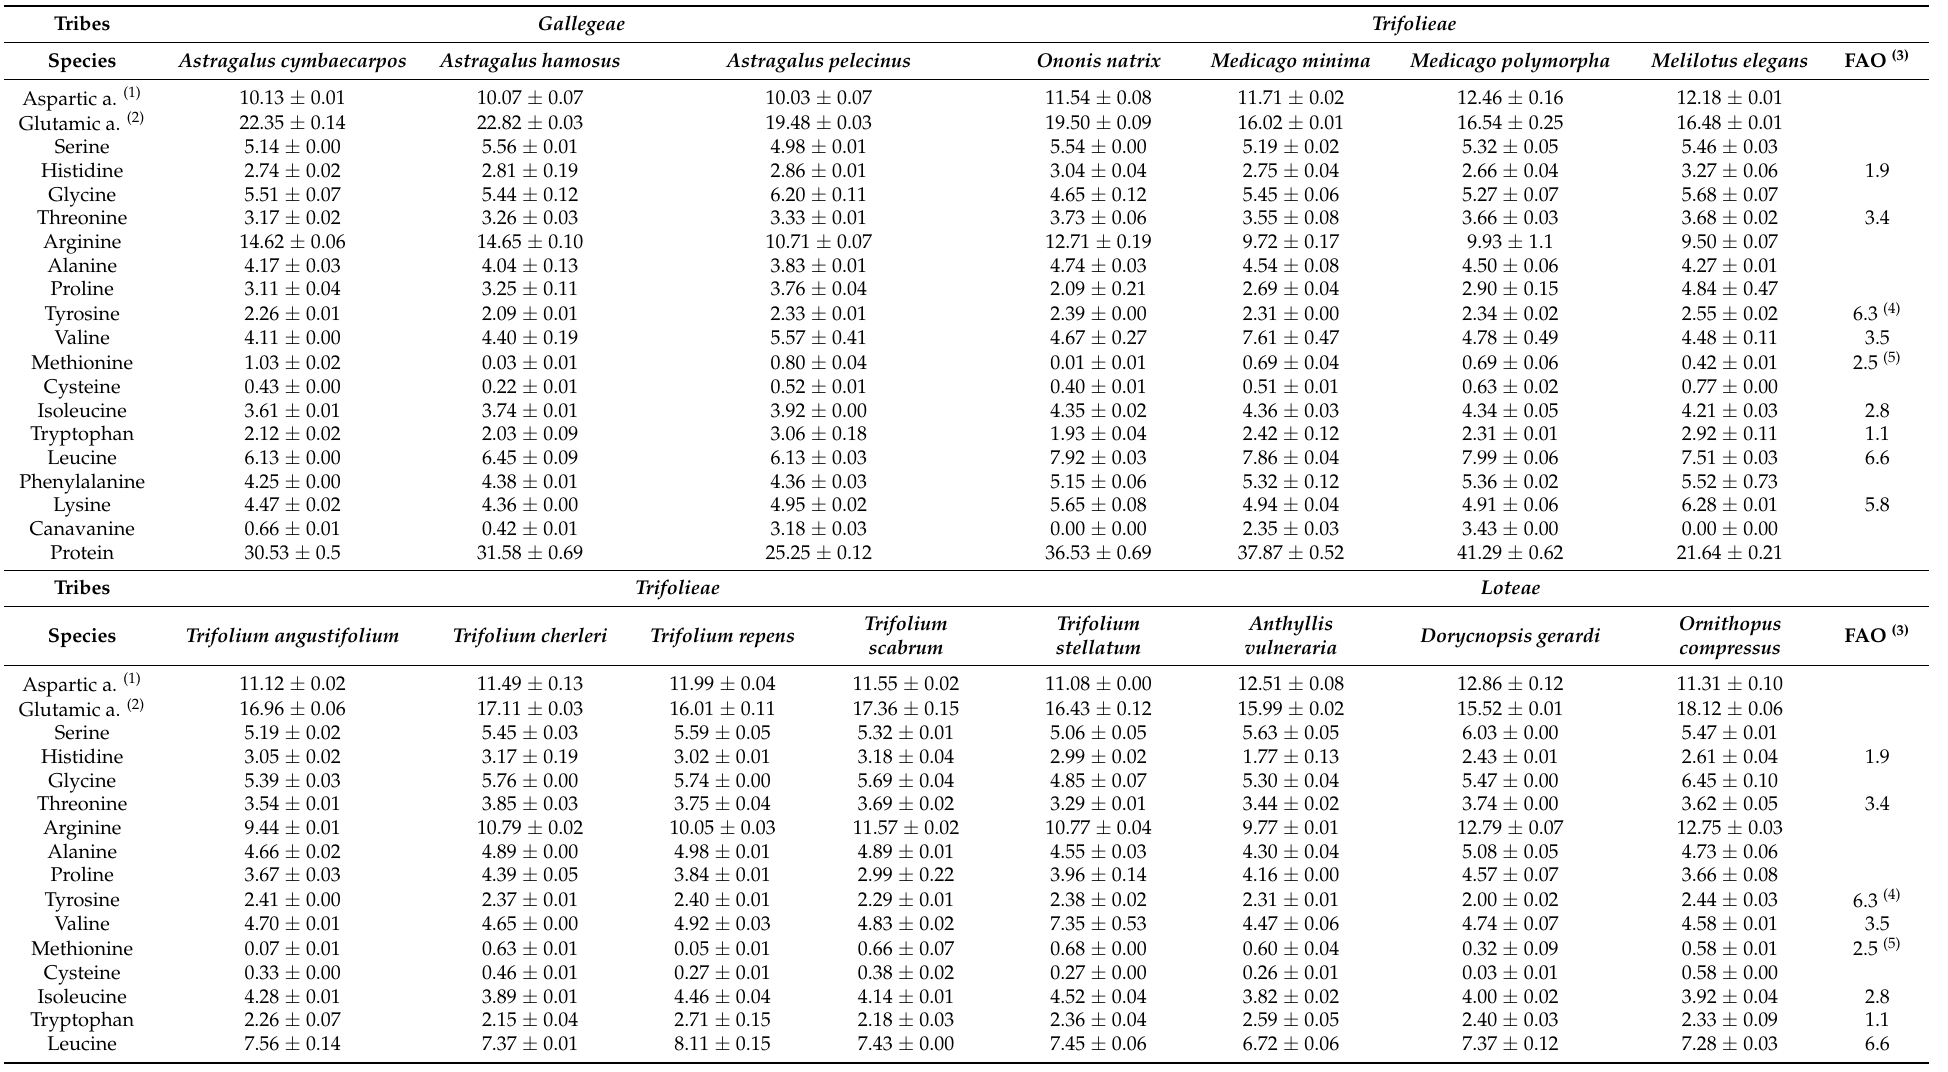
Table 1. Protein content and amino acid composition in seeds. Data expressed as g/100 g protein are the average ± sd of two